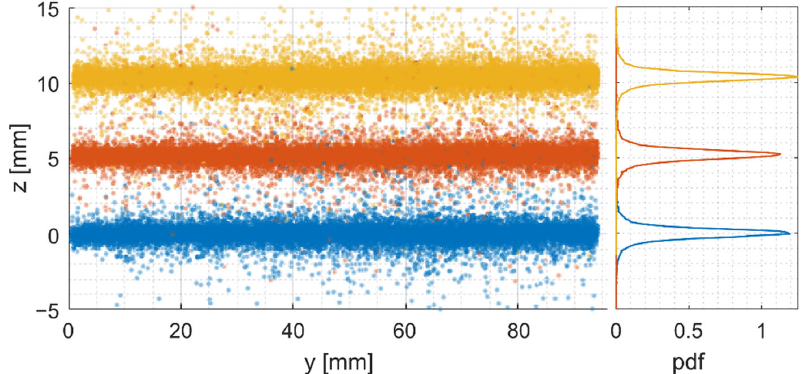
Figure 6. Measurement of the wavy specular surface at different height levels. The measured averages are 0 mm, 5.2 mm and 10.4 mm. The standard deviation is 0.79 mm. On the right, the probability density function (pdf) is shown.